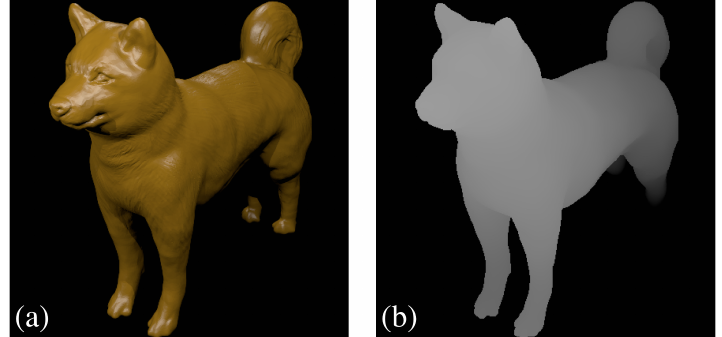
Figure 4. ( a ) Color image and ( b ) depth image of the 3D